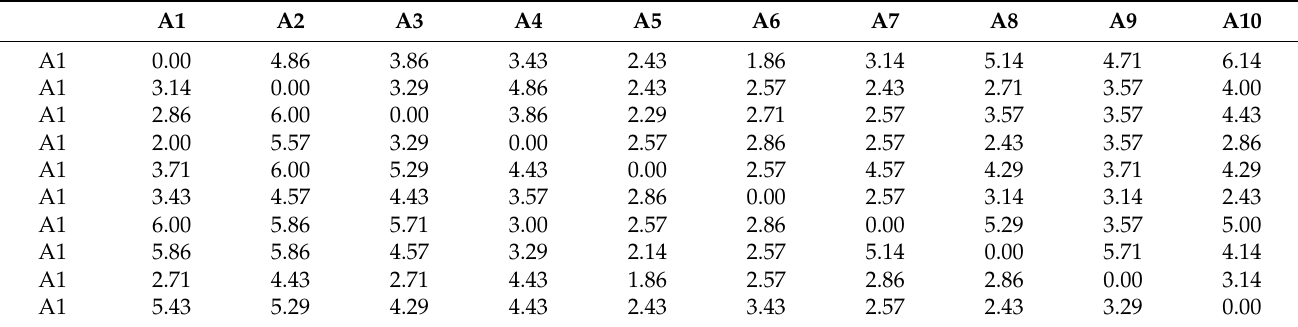
Table 9. Association matrix of risk factors. (A ×